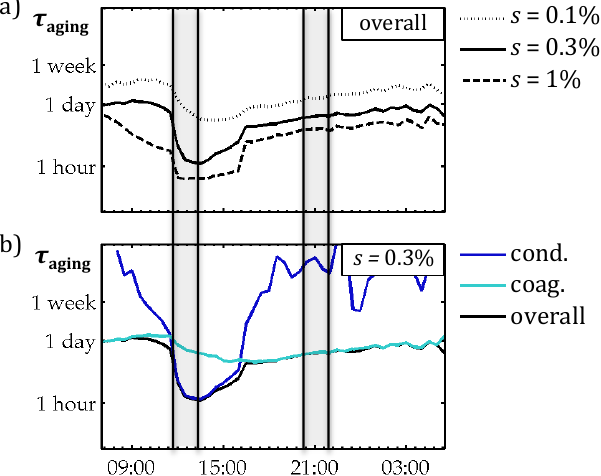
Figure 2. For a single scenario, overall aging timescale for s = 0 . 1%, s = 0 . 3%, and s = 1% in panel (a) and the overall, conden- sation, and coagulation aging timescales for s = 0 . 3% in panel (b) . The shaded regions show how the value of the aging timescale re- flects changes in per-particle characteristics, which correspond to Fig. 1. Short aging timescales correspond to rapid increases in par- ticle size and hygroscopicity (Fig. 1b), and long aging timescales correspond to slow changes in particle properties (Fig.